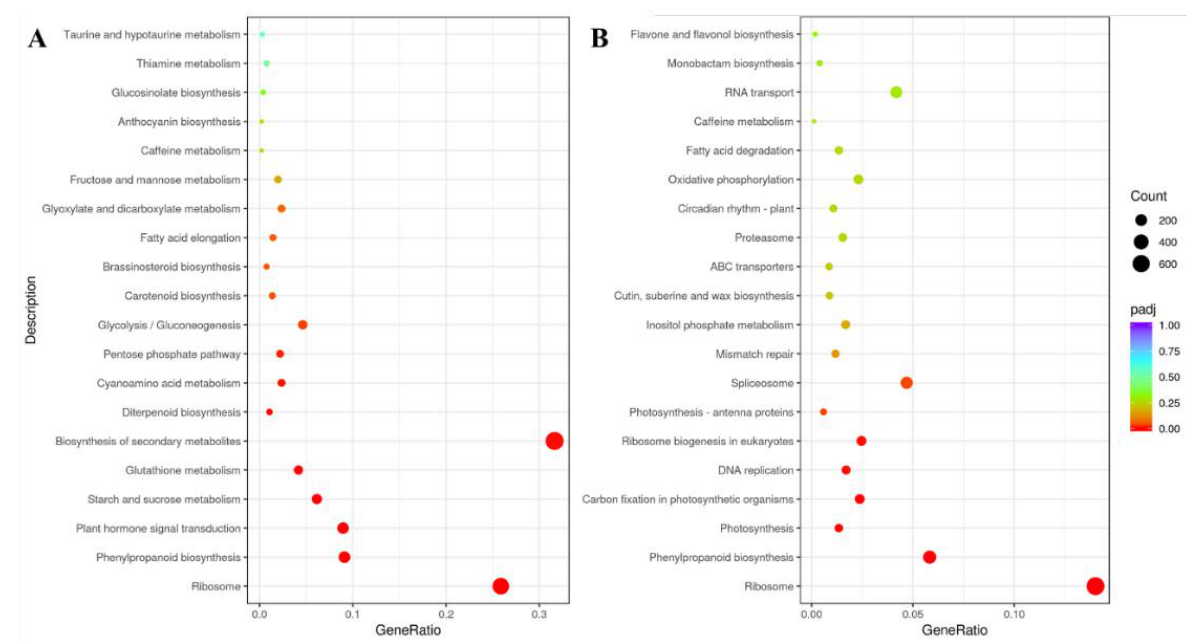
Figure 3. KEGG enrichment scatter diagram. ( A ) KEGG enrichment scatter diagram 24 h after dihydrocoumarin treatment. ( B ) KEGG enrichment scatter diagram 48 h after dihydrocoumarin treatment.